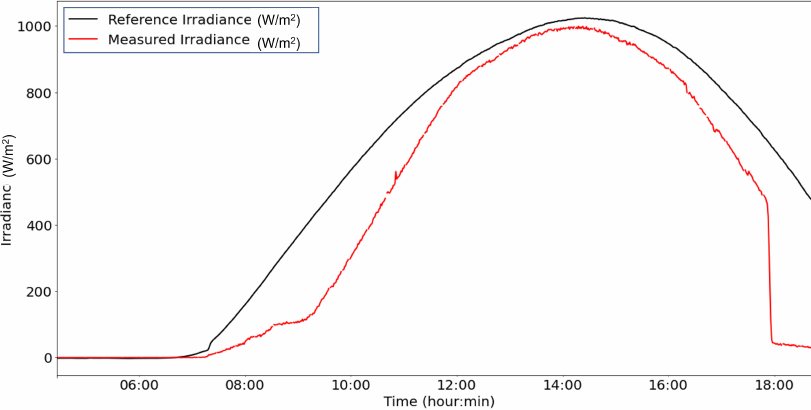
Figure 16. Example of collected data received in-plane